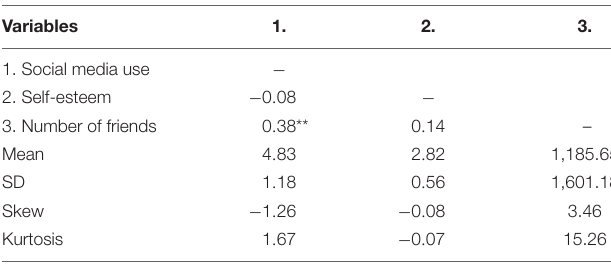
TABLE 1 | Descriptive statistics and intercorrelations of all variables ( N =